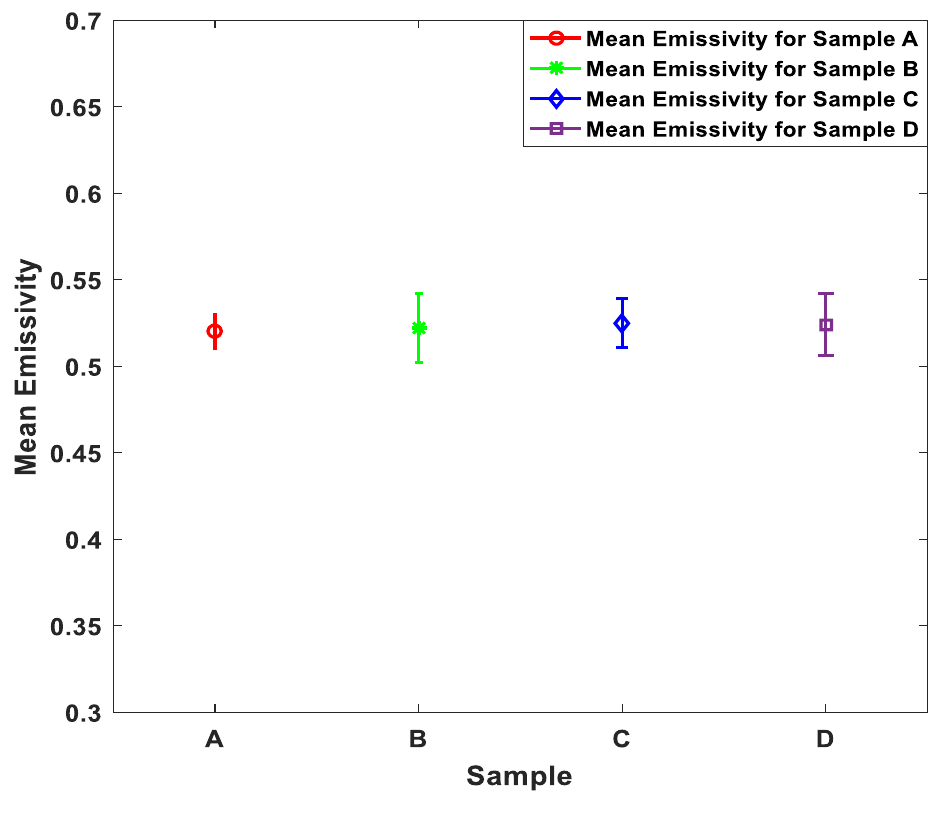
Figure 6. Mean emissivity values and standard deviation bars for porcine skin samples A, B, C, and D. The samples were taken from the back region of the same animal.